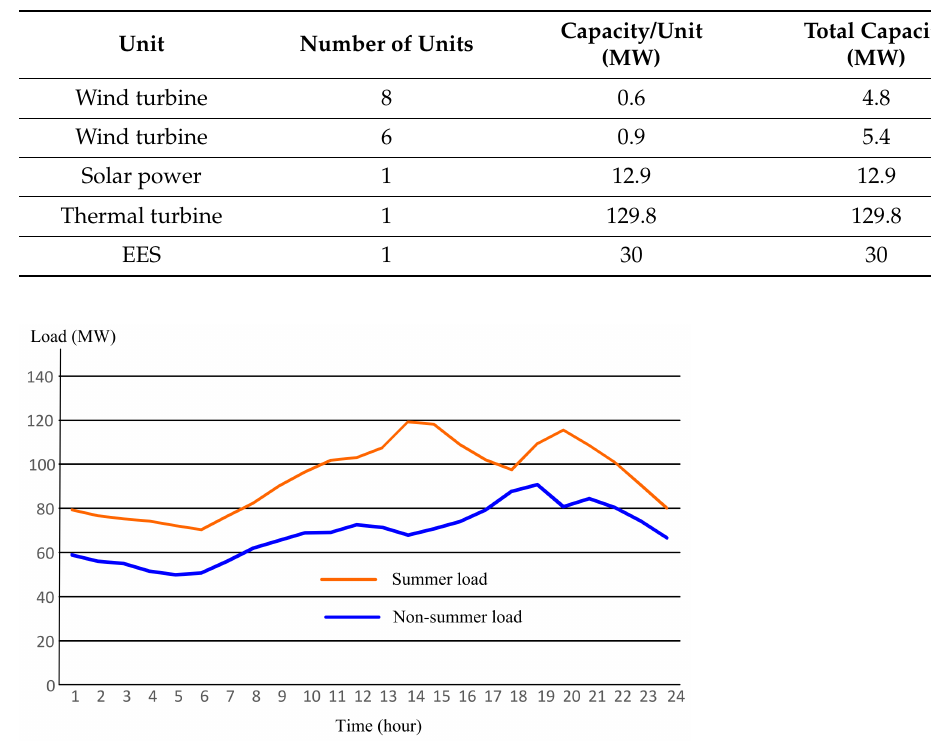
Figure 6. Summer and non-summer load profile